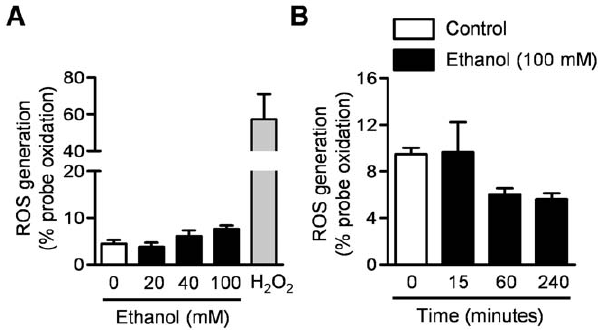
Figure 3. Alcohol does not increase ROS generation in alveolar epithelial cells. ( A ) MLE-12 cells that stably express a mitochondrially localized oxidant sensitive GFP probe were treated with different doses of ethanol (0-100 mM), media (negative control) or H 2 O 2 (positive control) and ROS generation was measured 4 hours later. ( B ) The same cells were treated with ethanol (100 mM) or media (control), and ROS generation was measured at different time points. N $ 3 for all measures, *p , 0.05 for comparison with untreated